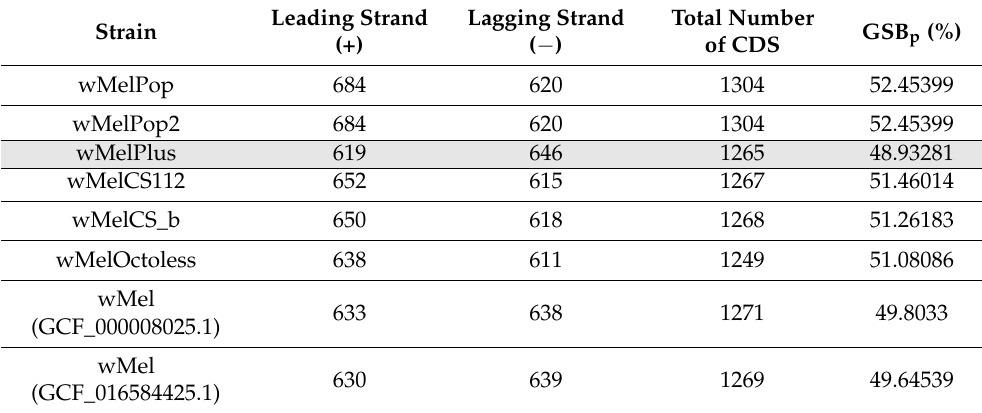
The data of strain of the interest (wMelPlus) are highlighted in